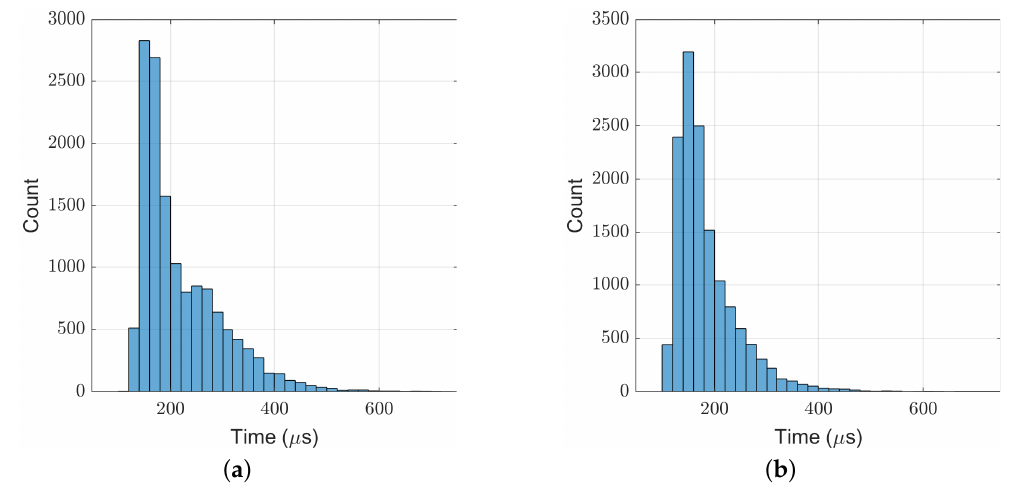
Figure 11. Computation time cost of TP-MPC in the frontal impact test. ( a ) 9 kg ball; ( b ) 11 kg